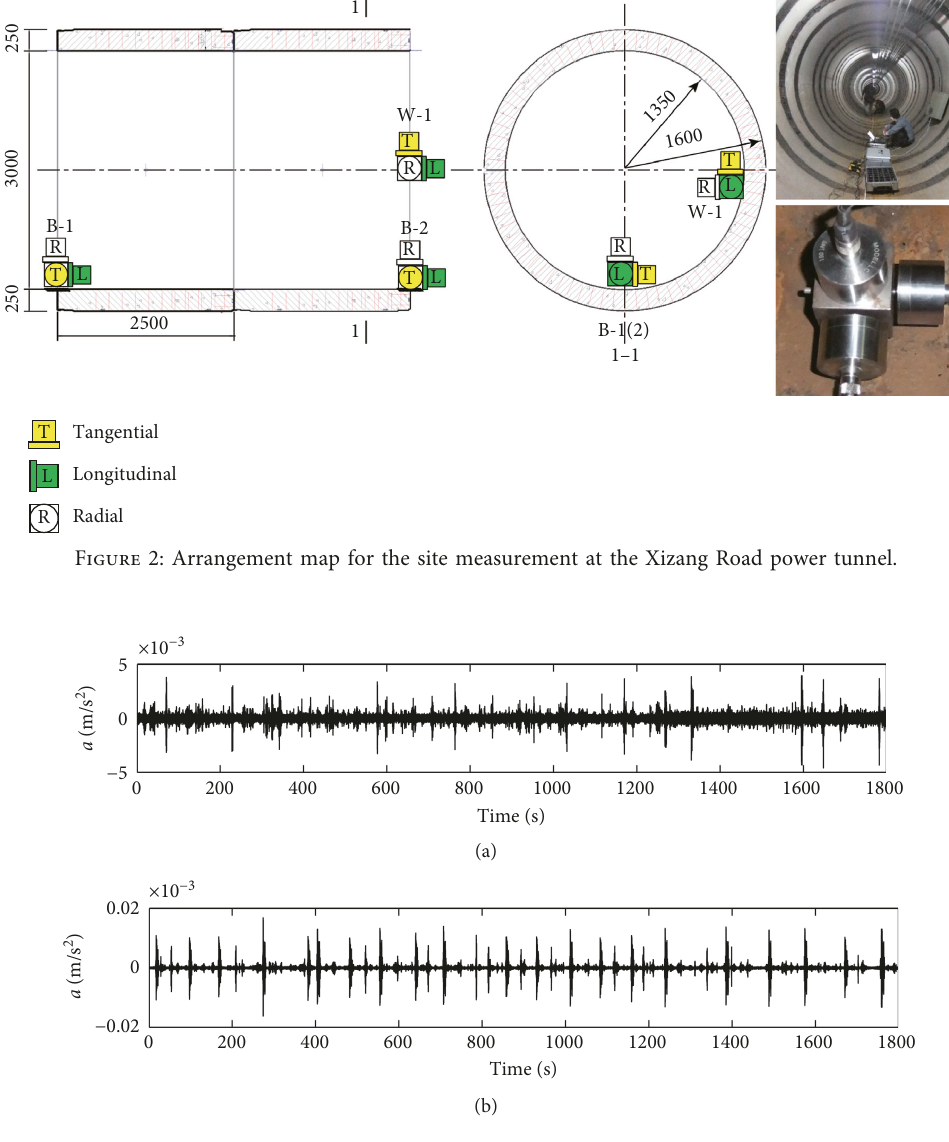
Figure 3: The time history of the acceleration for the measurement points B-1: (a) at nighttime; (b) at